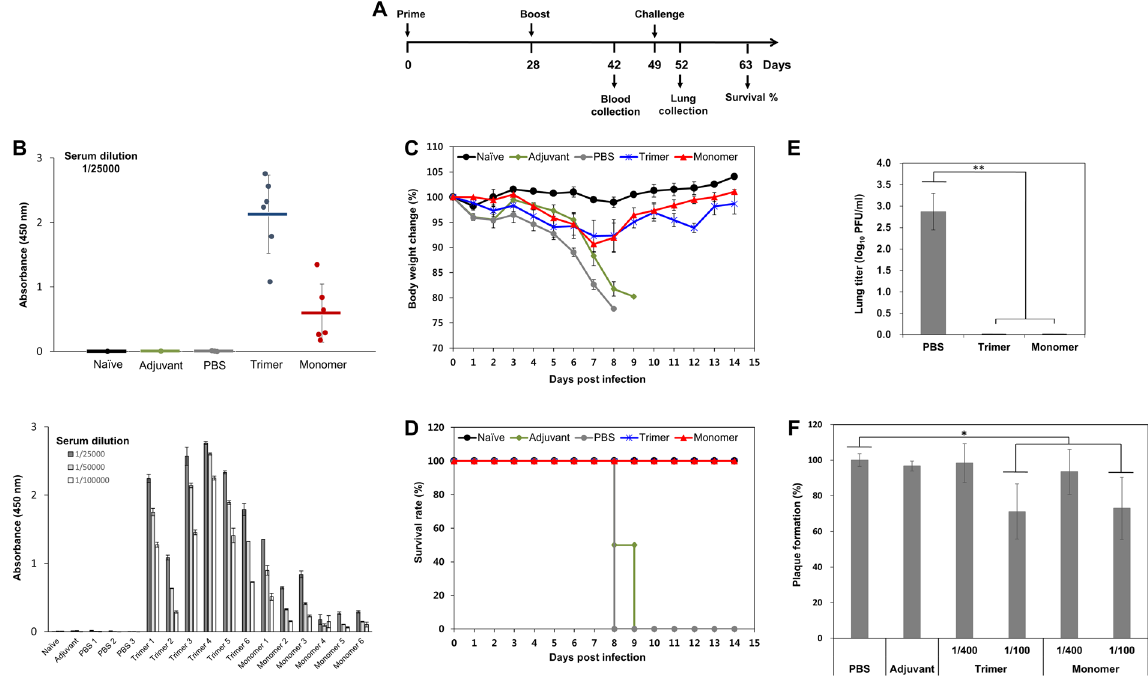
Figure 3. Protection of mice against virus infection by HA monomer. ( A ) Schedule of mouse immunization, sample collection and infection. BALB/c mice were immunized subcutaneously with 20 µ g of recombinant HA antigen. Four weeks later, the mice were boosted with the same amounts of HA antigen. The groups were naive, wild-type trimer, mutant monomer, PBS control, and adjuvant control. After three weeks of the boost, the mice were challenged intranasally with mouse-adapted PR8 in PBS (3 MLD 50 ). ( B ) IgG antibody titration from sera specific to HA antigens at a dilution of 1/25000 (upper panel) and at two-fold dilution starting with a dilution of 1/25000 (lower panel) were evaluated by ELISA. At day 42 that is at 2 weeks after the boost, the blood from mice of all groups were analysed for antibody response. Each individual dot represents the value from a single mouse, and the horizontal line represents the median value for the group. ( C ) Body weight changes and ( D ) survival rate of PR8-challenged groups. The percentages of body weight changes and survival rates were monitored daily until 14 dpi. Body weight data are the means ± SD for six mice per group ± SD. ( E ) Viral lung titers by PFU/ml at 3 dpi in BALB/c mice infected with PR8 virus. Values represent the means ± SD and statistical significance was defined as ** p < 0.01. ( F ) Plaque reduction neutralization assay. Serum samples were initially diluted at 1:10 and 1:40, and PR8 virus was added to each diluted serum sample tubes at the volume ratio of 9:1. The virus- serum mixture was incubated for 60 min and added to the MDCK cells at 37 °C and 5% CO 2 for 60 min. The presence of virus–infected cells was indicated by the formation of viral plaques, and PR8-infected cells with PBS and adjuvant were used as controls. * p <